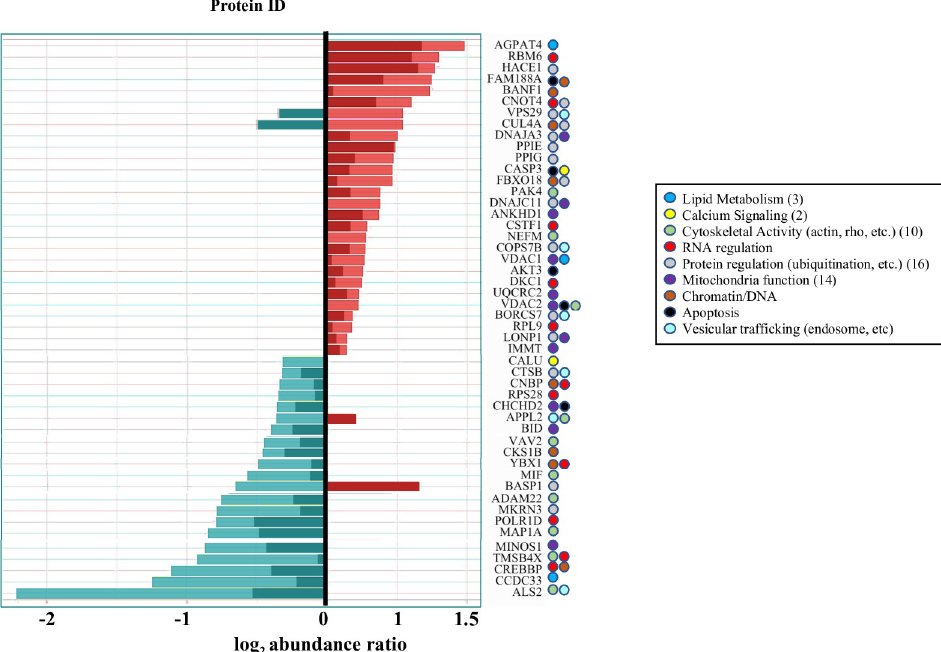
Fig 7. Protein binding components of Δ P. A change in protein levels measured by the log 2 abundance ratio measures within the A β 42 and A β 42 + Bgtx treatment conditions. Color shading highlights the impact of treatment condition on protein expression. Light (A β 42 ); dark (A β 42 + Bgtx). The function of each protein is shown using colored dots.